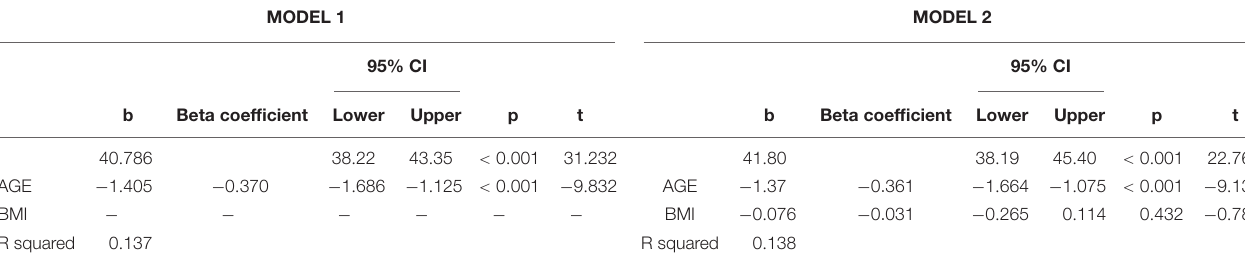
TABLE 3 | Representation of the bivariate (MODEL 1) and multivariable (MODEL 2) ordinal regression.